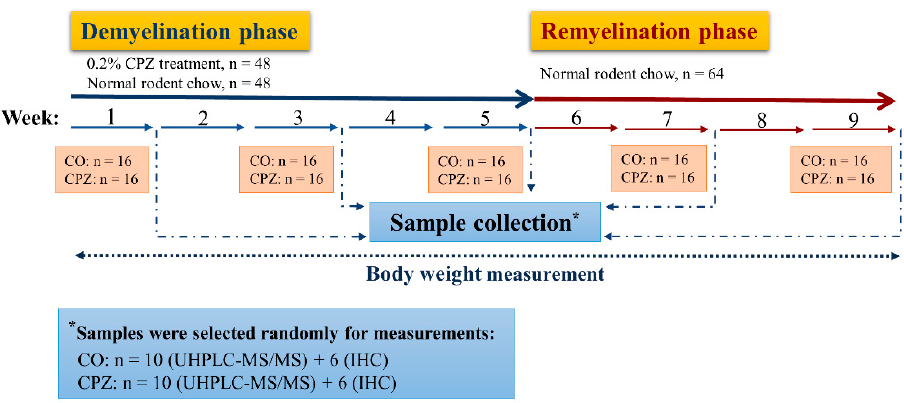
Figure 2. Timeline of the experimental procedure used. CO: control group; CPZ: cuprizone group; IHC: immunohistochemical studies; n: the number of animals; UHPLC-MS/MS: Ultra-high-performance liquid chromatography with tandem mass spectrometry; *: random sample selection was applied for both measurements in the CPZ-treated and the CO groups.